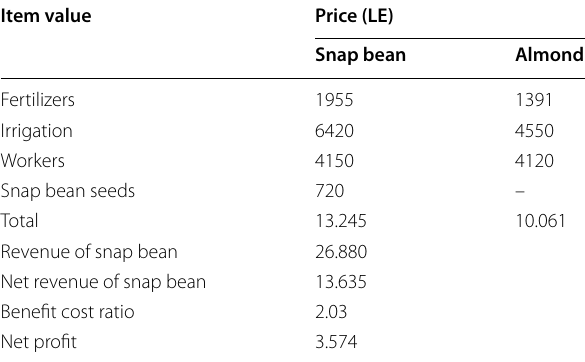
Values with diferent letter across the same row are signifcantly diferent ( p < 0.05) Table 6 Economic analysis of intercropping almond with snap bean Item